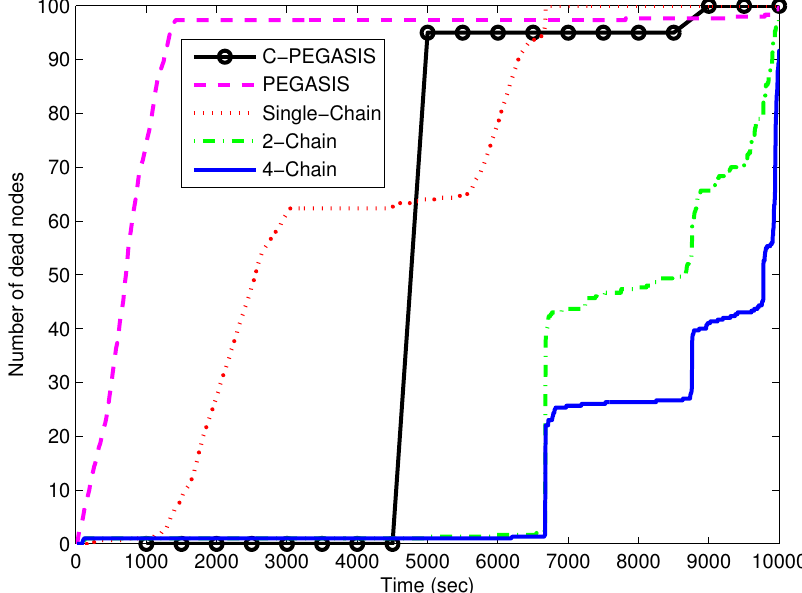
Figure 8. Number of dead nodes in 4-chain, 2-chain, single chain-based routing and